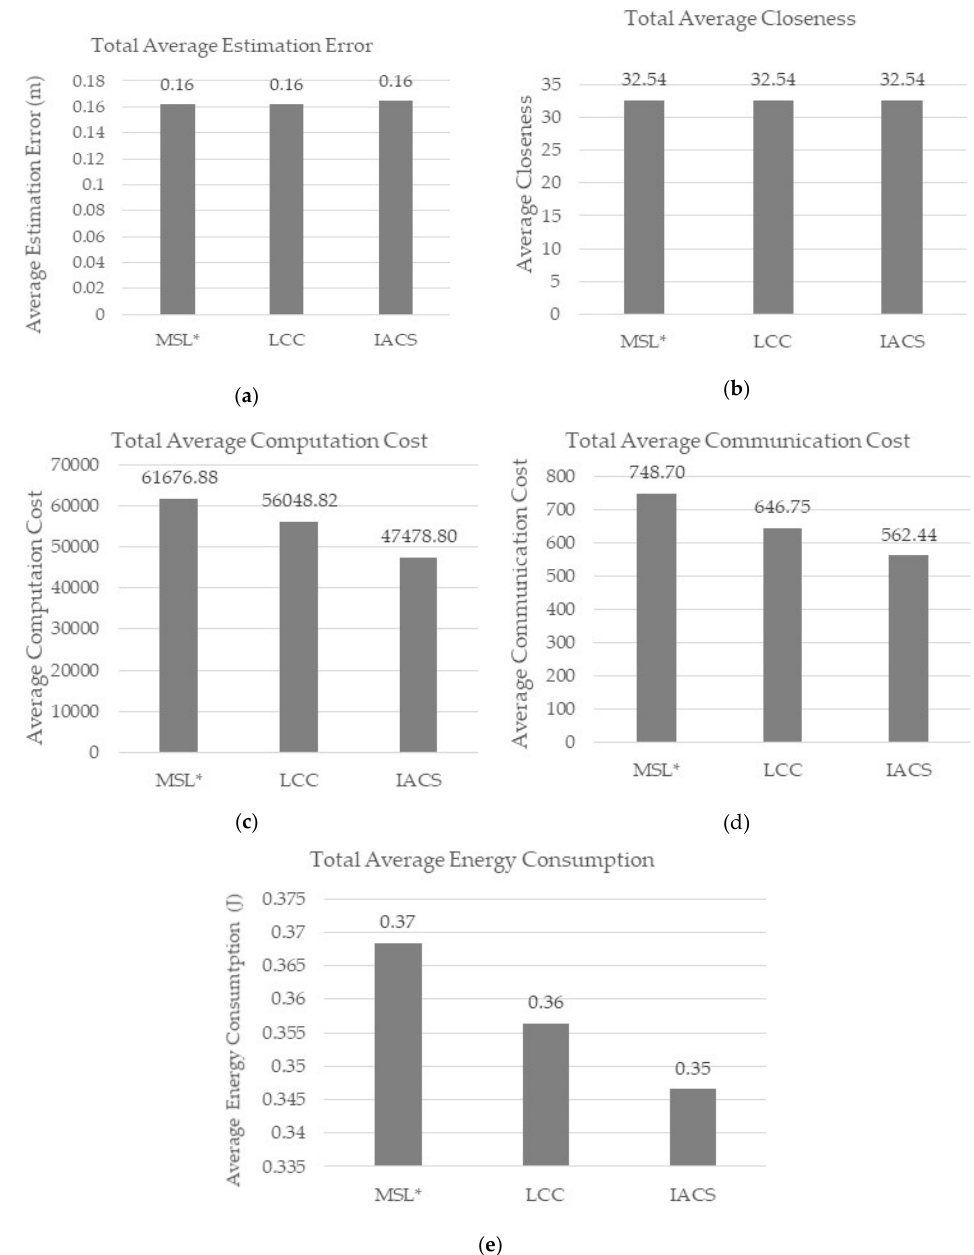
Figure 6 . ( a ) Total Average Estimation Error, ( b ) Total Average Closeness, ( c ) Total Average Computation Cost, ( d ) Total Average Communication Cost, and ( e ) Total Average Energy Consumption for Default Parameter Scenario.